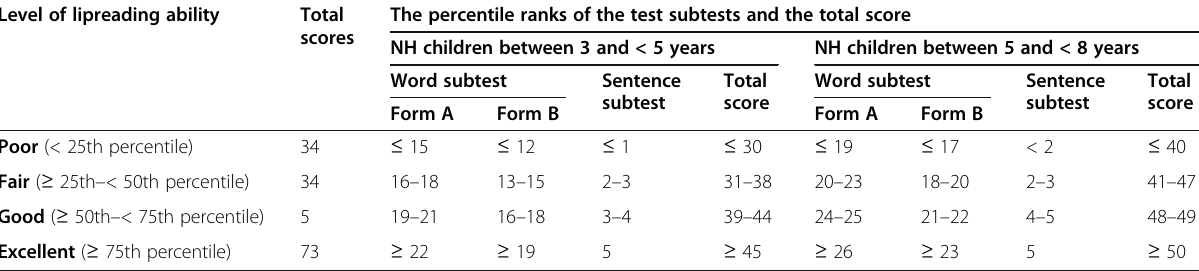
Table 3 Ranks of percentiles and scores of the Arabic lipreading test among the NH children Level of lipreading ability Total The percentile ranks of the test subtests and the total score scores NH children between 3 and < 5 years